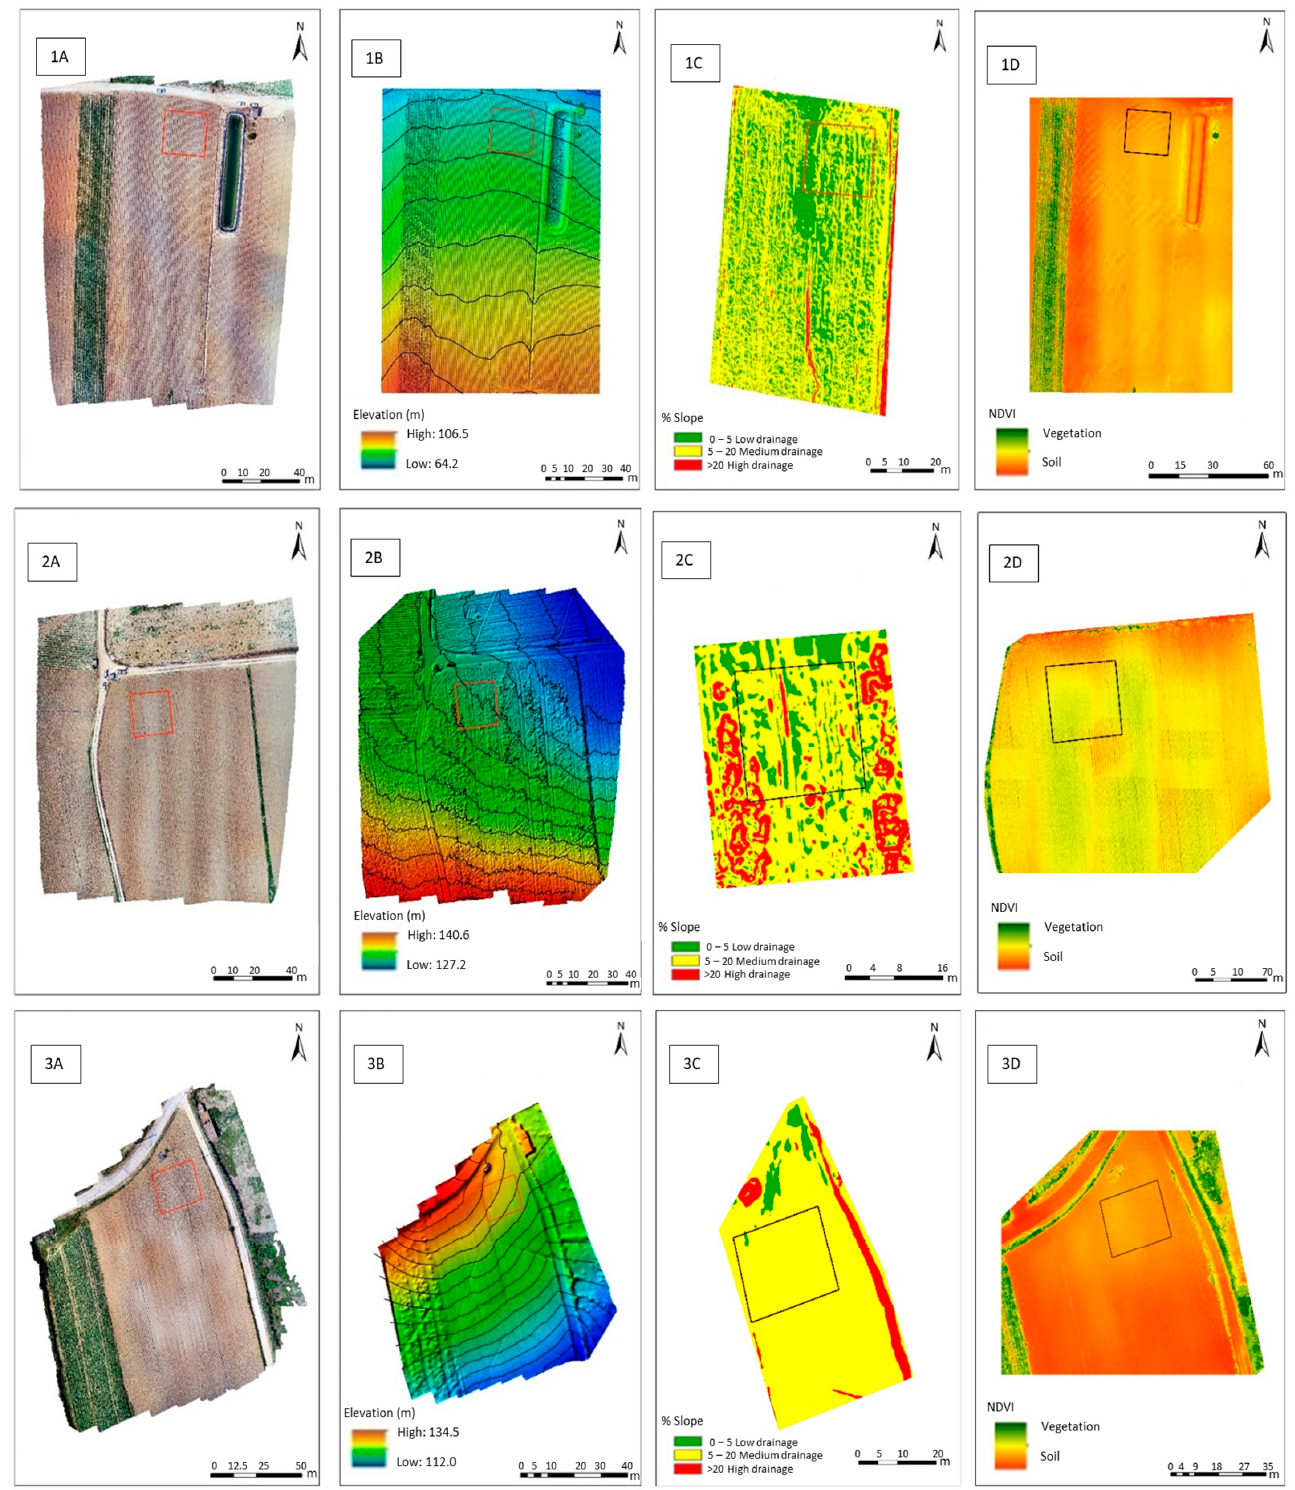
Figure 1. Orthophotomaps of S. tuberosum fields (1-Moledo, 2-Casal Galharda and 3-Boas Águas). Indication (in red) of limits of the three fields ( 1A , 2A , 3A ); Digital elevation model of the fields ( 1B , 2B , 3B ); Digital map of slopes of the fields ( 1C , 2C , 3C ); NDVI model of the fields ( 1D , 2D , 3D ). Information collected before tubers harvesting and biofortification treatments (18 May for the three fields).